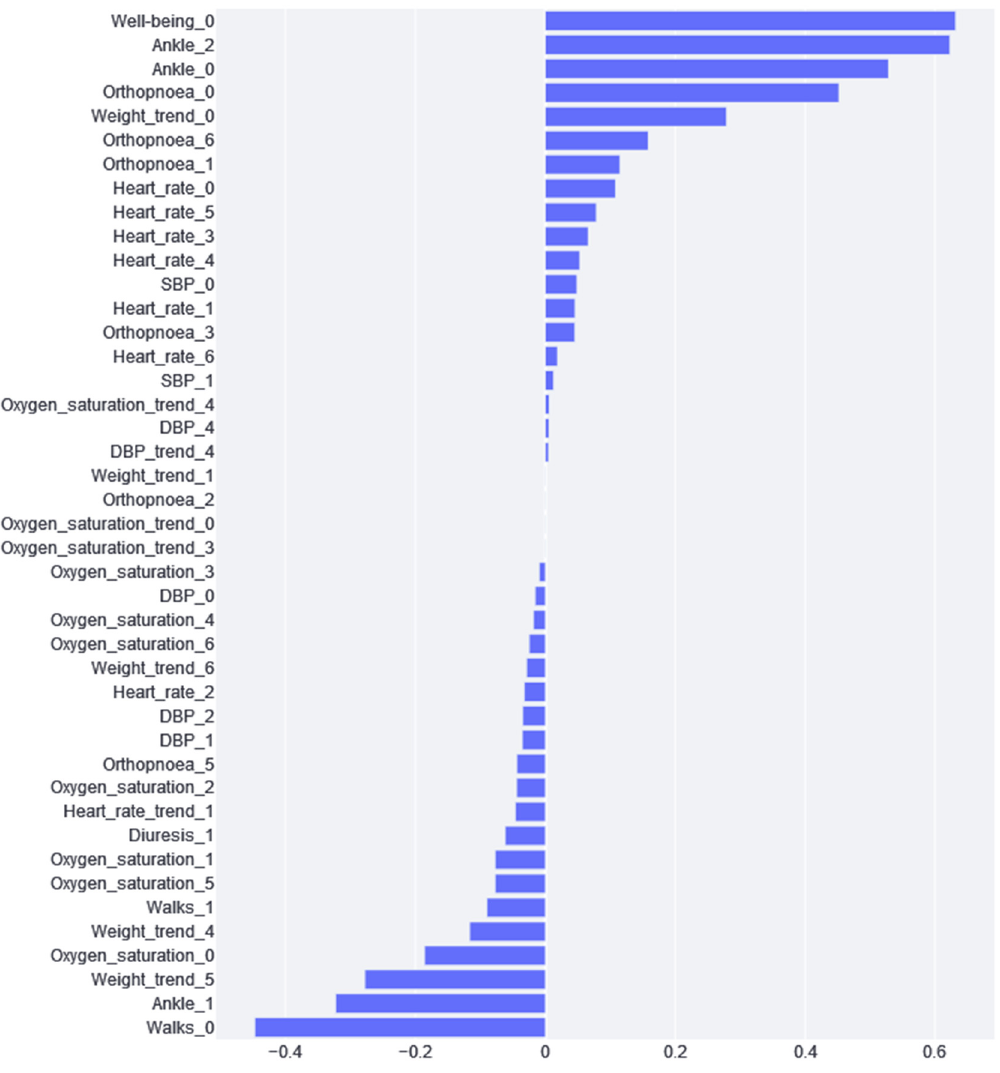
Figure 6. Feature importance calculated from the logistic regression model.